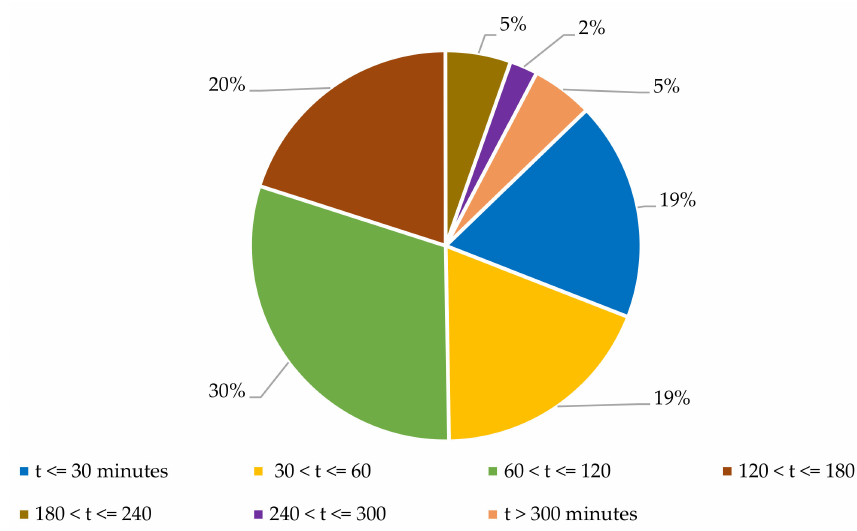
Figure 5. Parking time at PRE charging stations ([65], compiled and calculated by authors).